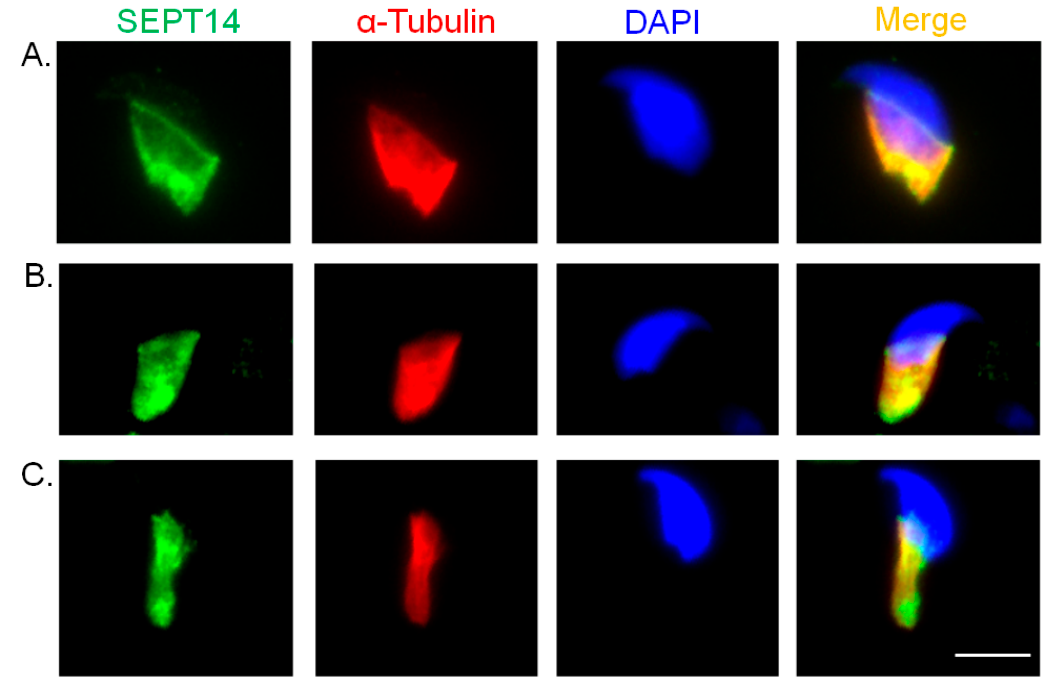
Figure 1. Immunofluorescence detection of SEPT14 during murine sperm head shaping. SEPT14 signals showed multiple co-localizations with the manchette marker, α -Tubulin, in spermatids at step 8 ( A ), 9 ( B ), and 10 ( C ). SEPT14 (green), α -Tubulin (red), and DAPI (blue) stained images are shown, as well as merged images of SEPT14, α -Tubulin, and DAPI signals in spermatids. More than 10 male germ cells have been detected at different stages. Magnification, 1000×. Scale Bar: 10 μ m.